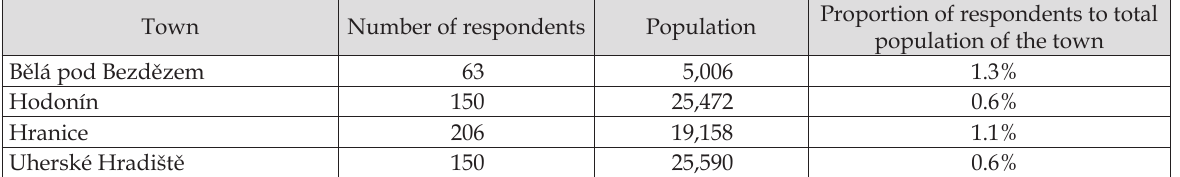
Table 2. Number of respondents in the municipalities concerned